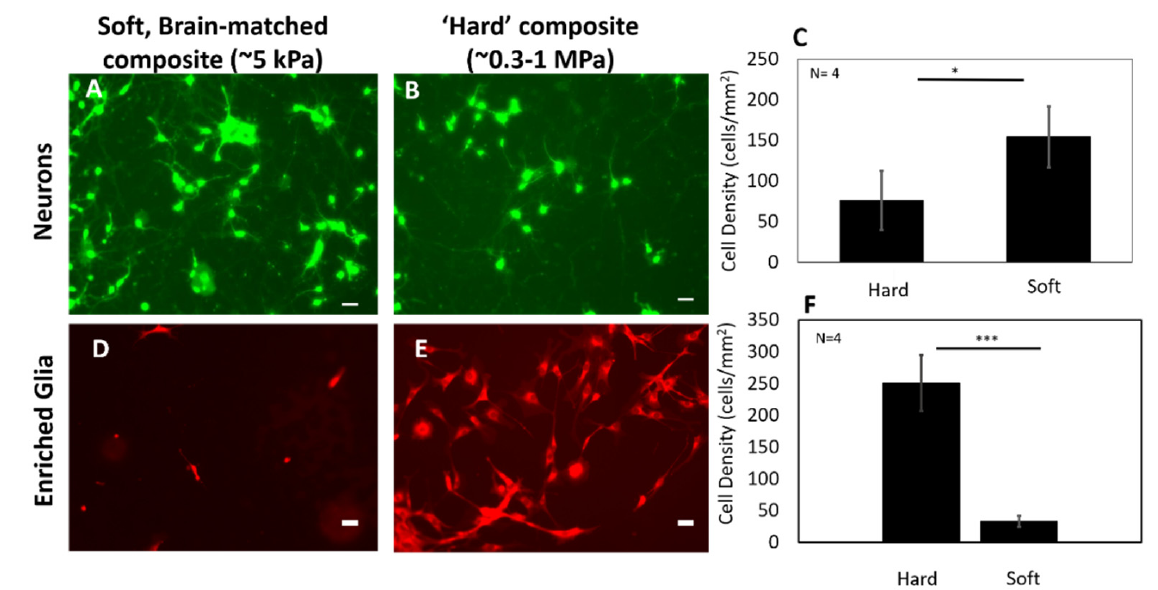
Figure 4. Comparison of cell proliferation and morphology of ( A – C ) cultured rat cortical neurons (DIV 7) and ( D – F ) enriched primary glial cultures (cultivated for ~36 h prior to imaging) from rat cortex cultivated on ( A , D ) hard silicone substrates ( n = 4 each condition) (0.3–1 MPa) and ( B , E ) soft coated silicone substrates ( n = 4 each condition) (5–10 kPa). ( C ) The neuron cell viability imaged using Calcein AM on soft substrates was significantly higher (* p < 0.05) compared to ‘hard’ composite substrates (right), where soft substrates had approximately 154 ± 37 cells/mm 2 and ‘hard’ substrates had approximately 76 ± 36 cells/mm 2 . ( F ) Cell densities for enriched glia cultures imaged using Mitotracker-CMXRos™ as a live cell marker are significantly increased for harder substrates (250 ± 50 cells/mm 2 ) compared to softer substrates (33 ± 17 cells/mm 2 ) (*** p < 0.001). Bar indicates 50 µm.